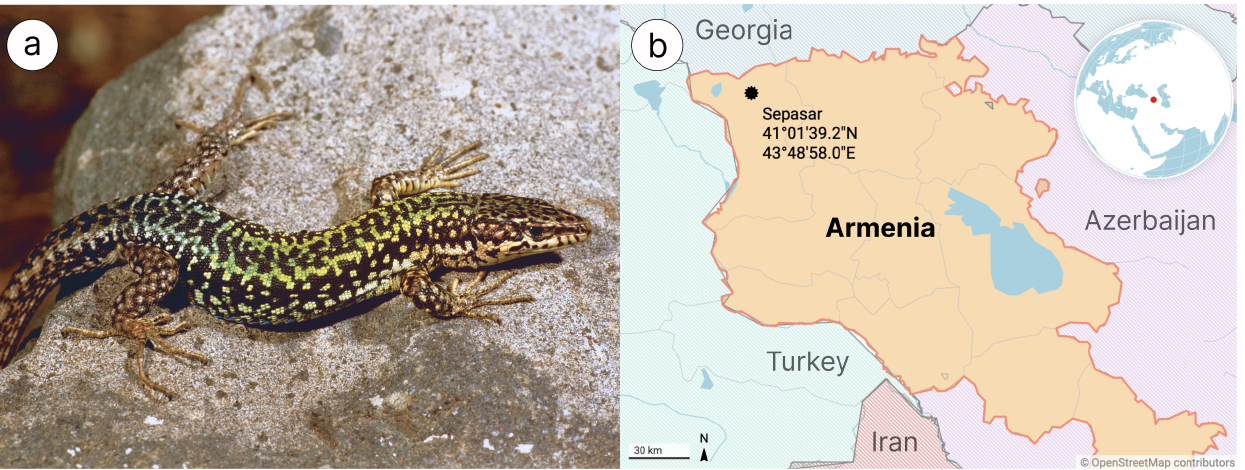
Figure 1. ( a ) Caucasian rock lizard Darevskia valentini , Armenia, from Arakelyan et al. [31]. ( b ) Map with DNA and RNA samples location (generated with